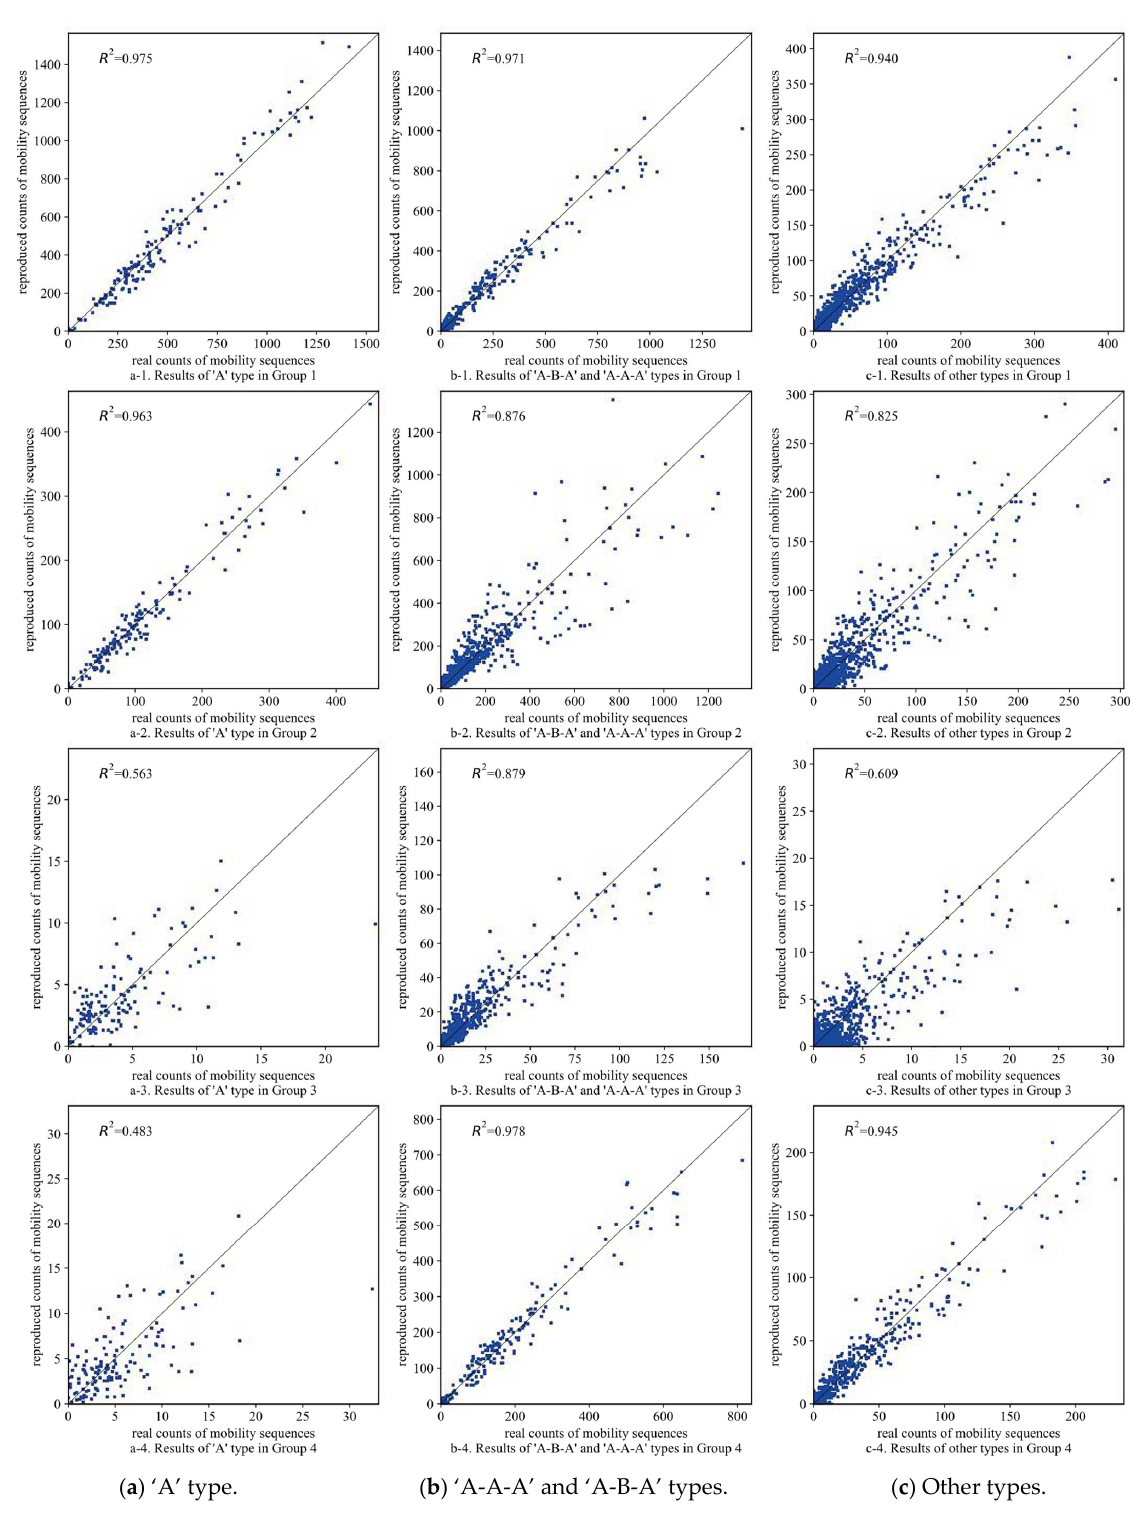
Figure 9. Spatial evaluation for the reproduction results for 2008. ( a ) Results for ‘A’ type; ( b ) Results for ‘A ‐ A ‐ A’ and ‘A ‐ B ‐ A’ types; ( c ) Results for other types.